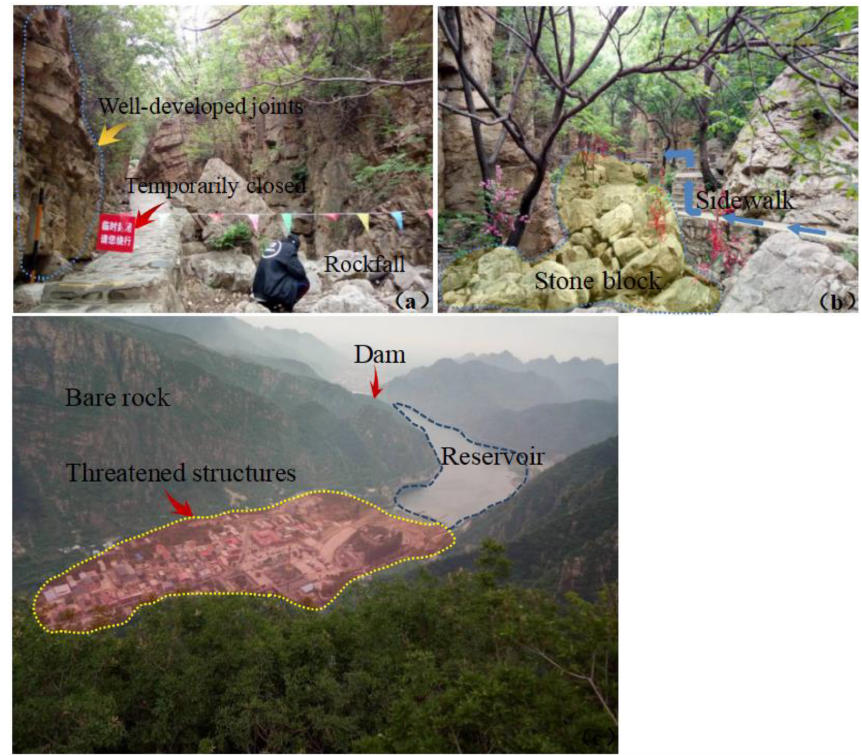
Figure 3. Shilin Gorge scenic spot. (a) Some scenic spots have been closed, and (b) the scenic area was heavily blocked by rockfill. (c) Structures threatened by debris flow.